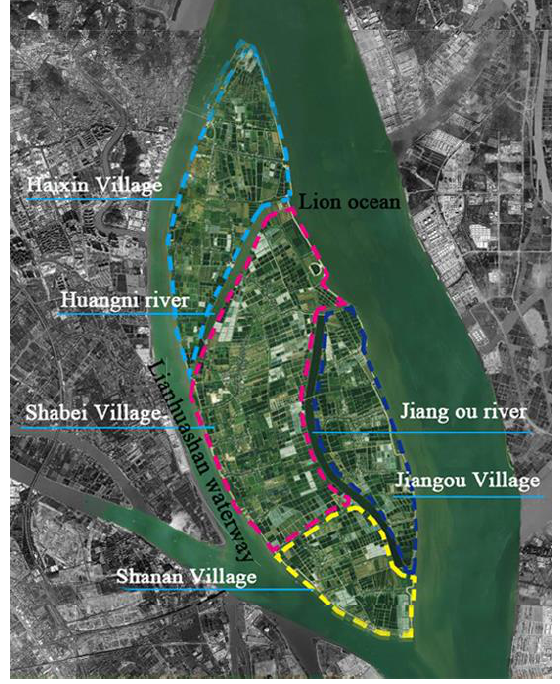
Figure 4. The layout of Haiou Island in Panyu District, Guangzhou (source: the authors). (2) Xiantang Village